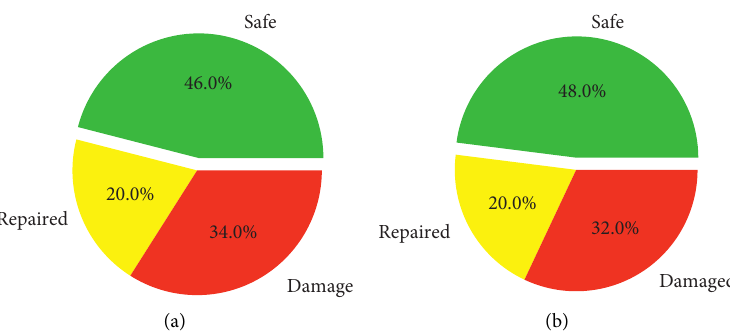
Figure 12: Damage distribution of the test dataset. (a) NDA results. (b) ANN model results.